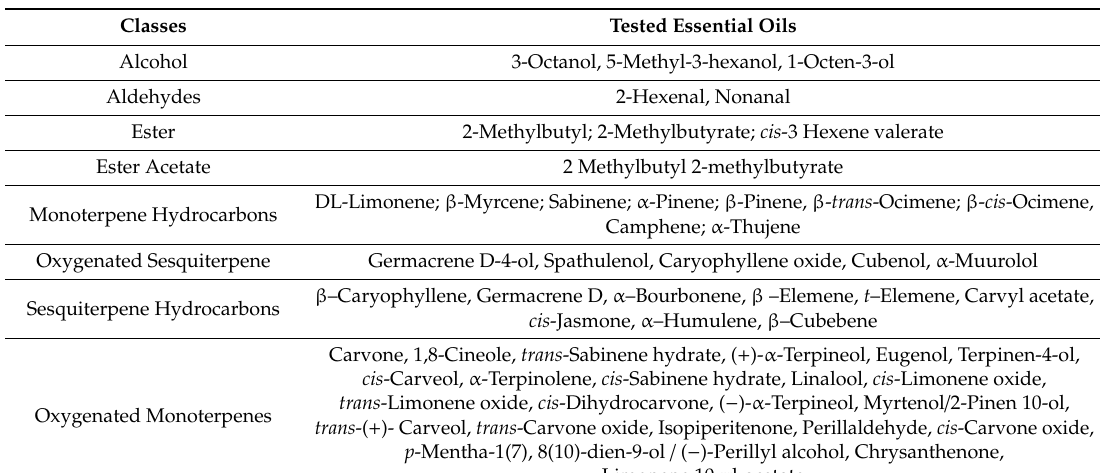
Table 1. List of tested essential oils, grouped in their own